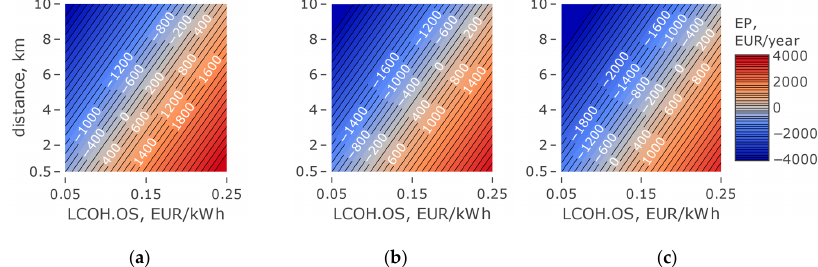
Figure 15. The Yearly Economical Profitable as a function of Levelized Cost of Heating from non- geothermal source (LCOH.OS) and distance between Geothermal Base Station and House, for Total Heat Demand (THD) = 25,000 kWh / year and for: ( a ) M-TES price = 2000 EUR; ( b ) M-TES price = 6000 EUR; ( c ) M-TES price = 10,000